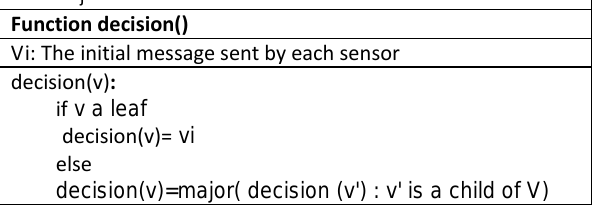
Fig.2. The proposed protocol and